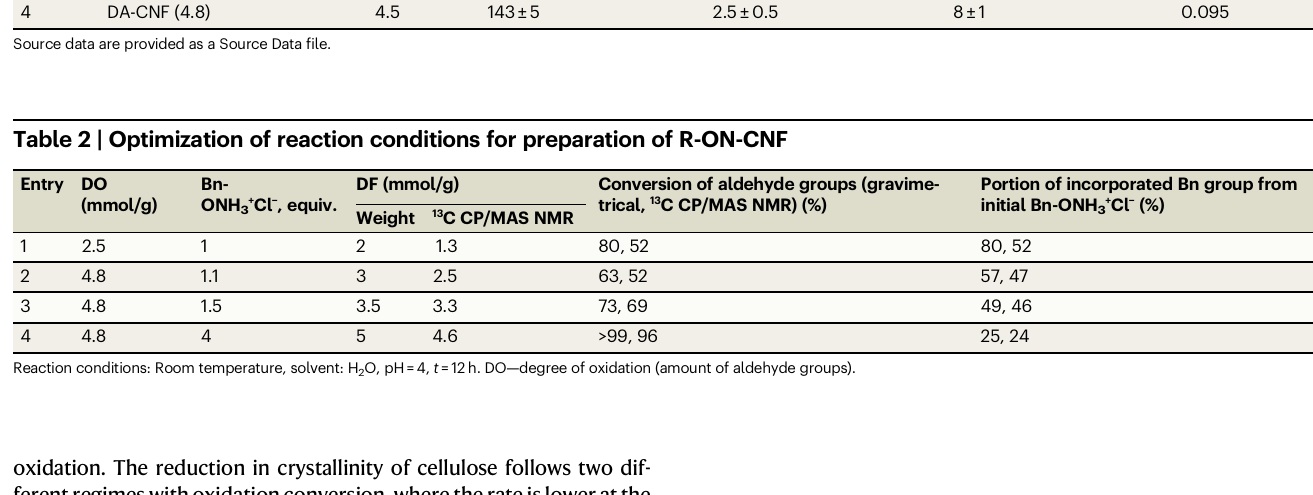
DA-CNF (4.8) Source data are provided as a Source Data fi le.